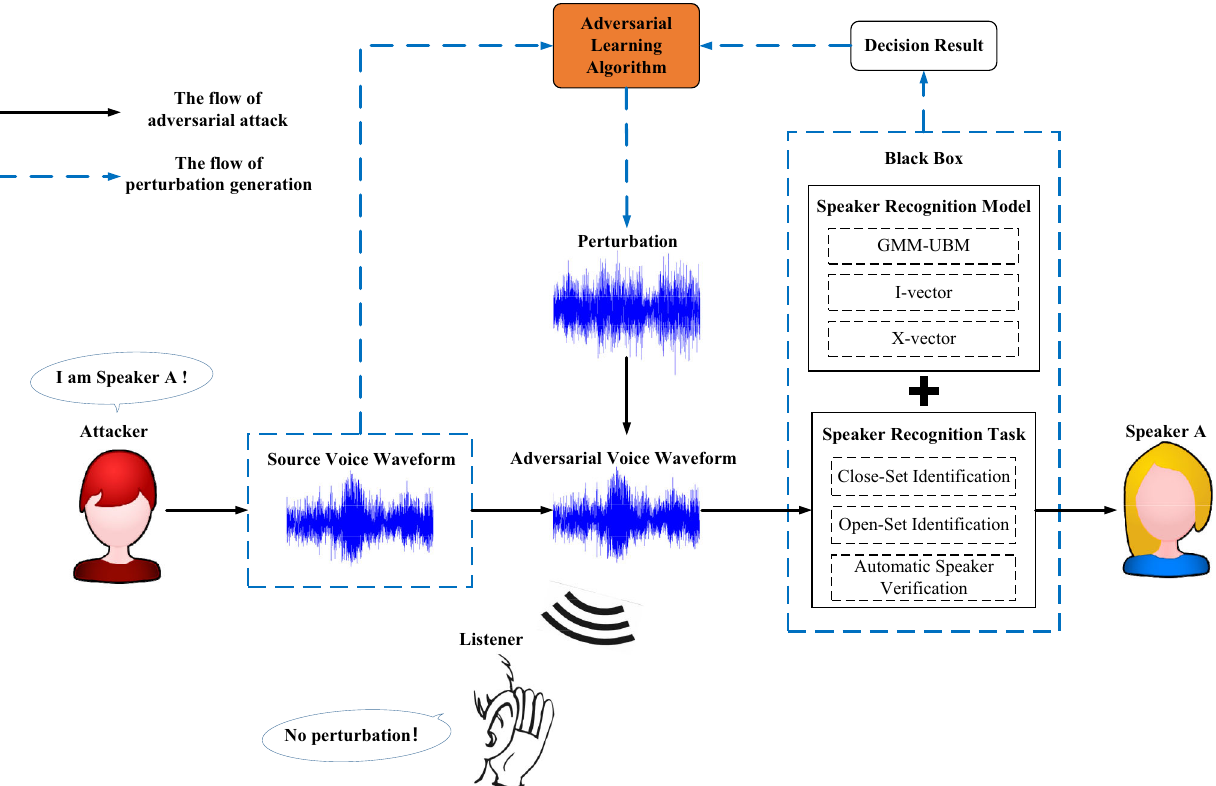
Fig. 1 Attacking scenario of this paper. The blue dotted line repre- sents the generation process of adversarial perturbations, and the black solid line represents the conducting process of an adversarial attack. An attacker first has the source voice. An adversarial learning algorithm subsequently generates a perturbation signal based on the source voice